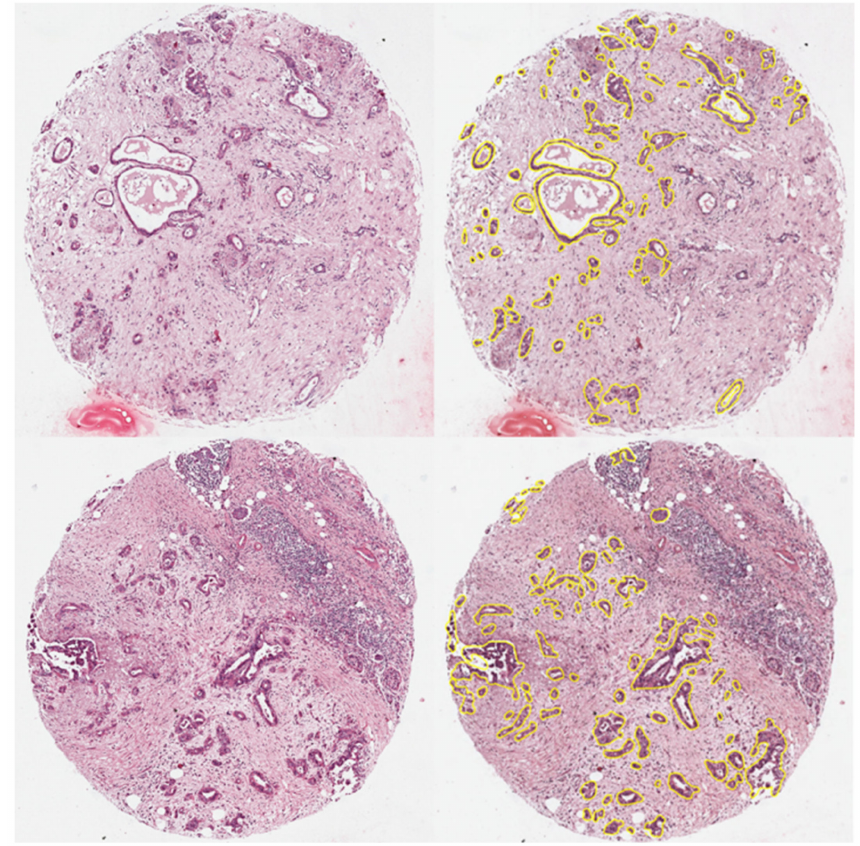
Figure 1. One exemplary core of a cholangiocarcinoma (CC) (top) and a pancreatic ductal adenocarci- noma (PDAC) (bottom), without (left side) and with annotation (right